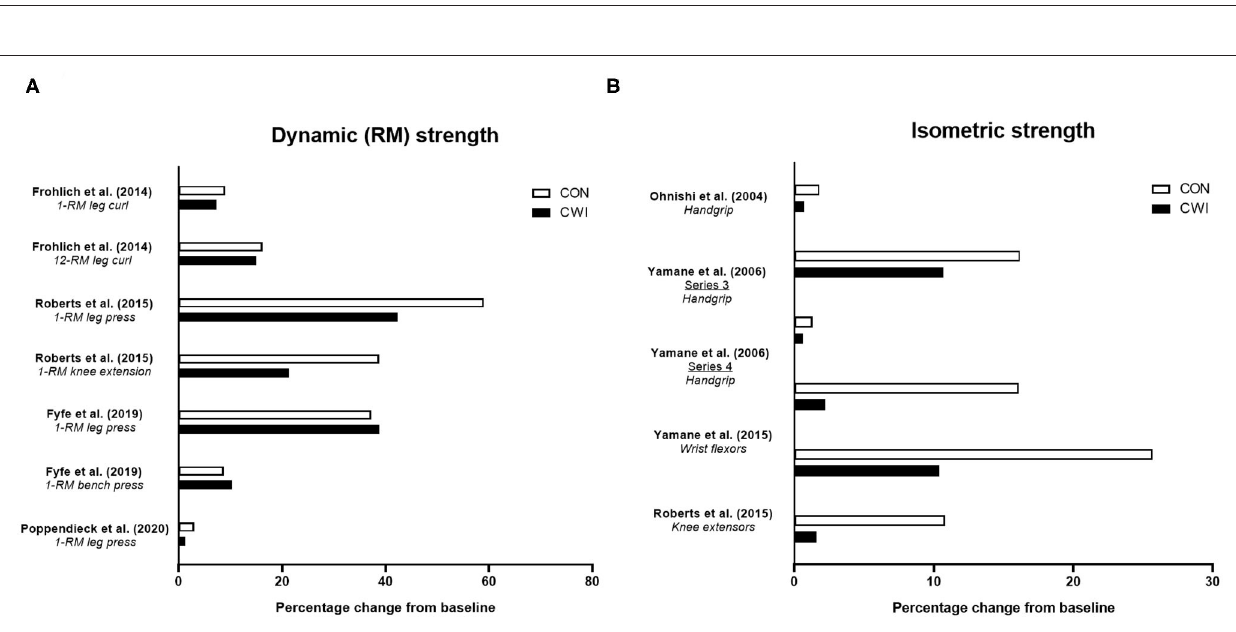
FIGURE 2 | Summary of studies investigating the effects of post-exercise cold water immersion (CWI) on changes in maximal strength with resistance training, including effects (shown as mean percentage changes from baseline to post-training) on dynamic repetition-maximum (RM) strength (A) and isometric or isokinetic strength (B) . Adapted from Broatch et al. (2018) with